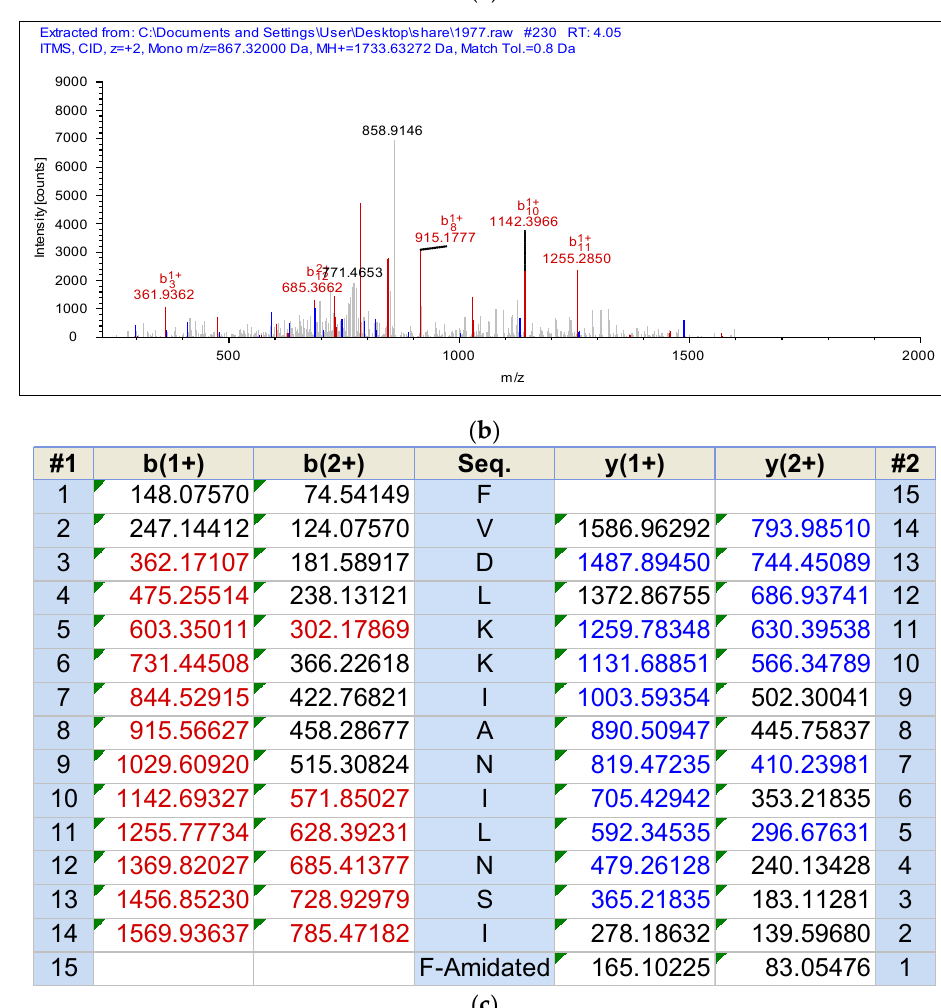
Figure 3. ( a ) RP-HPLC chromatogram of skin secretion of Rana chensinensis. The arrow indicates the retention time of Temporin-1CEh. ( b ) Annotated MS/MS spectrum of Temporin-1CEh. ( c ) Predicted singly- and doubly-charged b-ions and y-ions arising from MS/MS fragmentation of Temporin-1CEh. The observed b- and y-ions are indicated in red and blue typefaces.